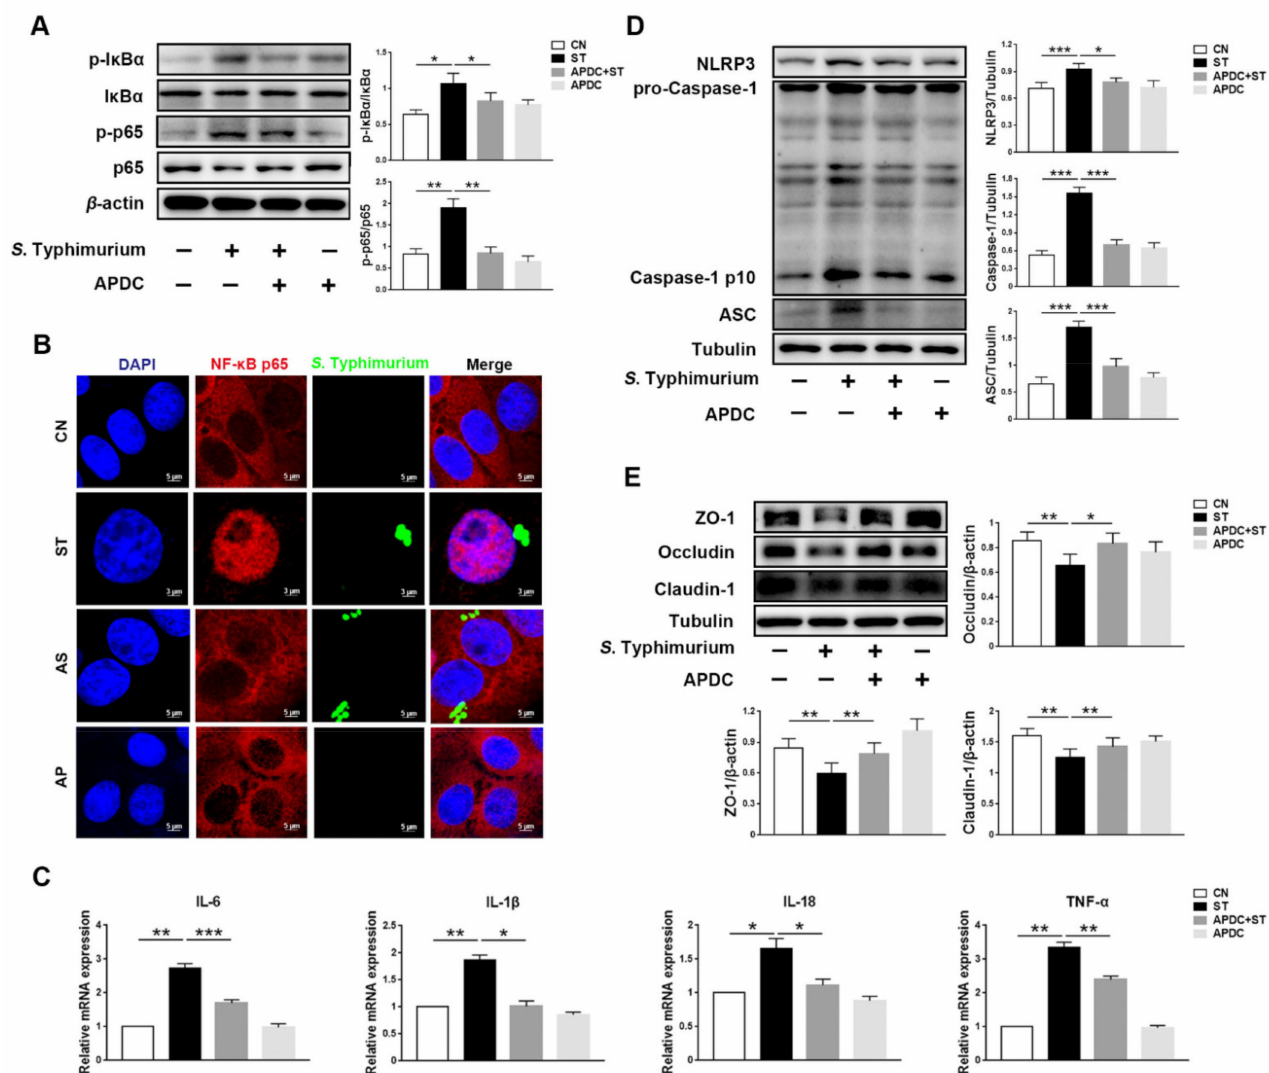
Figure 4. L. johnsonii L531 inhibits S. Typhimurium-induced activation of the NF- κ B pathway to maintain tight junctions. ( A ) Western blotting of p-I κ B α , I κ B α , p-p65, and p65. ( B ) Representative immunofluorescence images of S. Typhimurium (green), NF- κ B p65 (red), DAPI (blue) stains the nucleus. Scale bar, 5 µ m. ( C ) Pro-inflammatory cytokines mRNA expression levels in IPEC-J2 cells were detected by qRT-PCR. CN control, ST S. Typhimurium. ( D ) Western blotting of NLRP3, ASC, Caspase-1. ( E ) Western blotting of ZO-1, Occludin, Claudin-1. The panels show proteins or cytokines quantification using ImageJ software (version 1.50). The values are shown as the mean ± SEM; n = 3. * p < 0.05, ** p < 0.01, *** p <